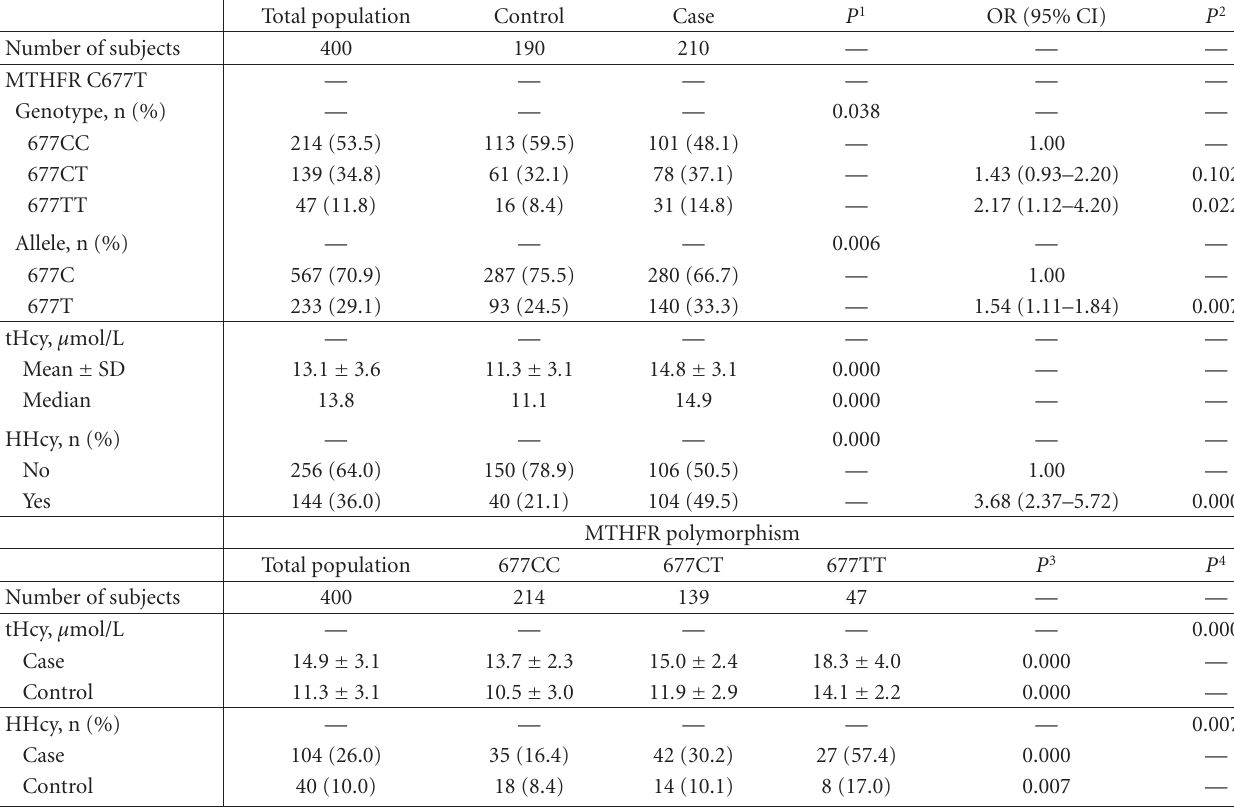
Table 2: Hyperhomocysteinaemia and MTHFR polymorphism distributions according to CAD, and HHcy distribution according to MTHFR polymorphism and CAD. P 1 is an MTHFR polymorphism and HHcy comparison ( chi-square test ) and Hcy comparison ( ANOVA and median tests ) between cases and controls. P 2 is the significant value of the hypothesis testing that the OR of CAD associated to MTHFR polymorphism and HHcy is 1. P 3 is a tHcy comparison between genotypes in cases and controls separately (Kruskal-Wallis test) . P 4 is a tHcy comparison between genotypes in total population ( Kruskal-Wallis test ).